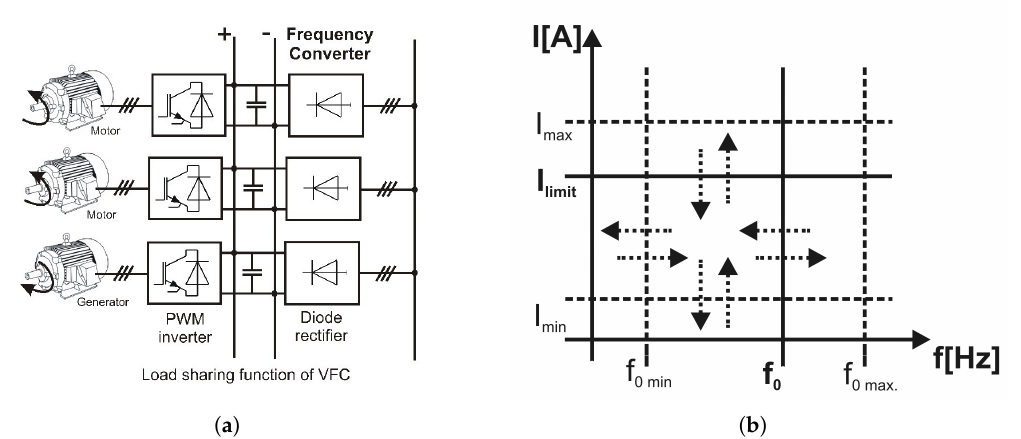
Figure 6. Functions of drive voltage frequency converter (VFC): ( a ) load sharing in drive VFCs, ( b ) current limiter